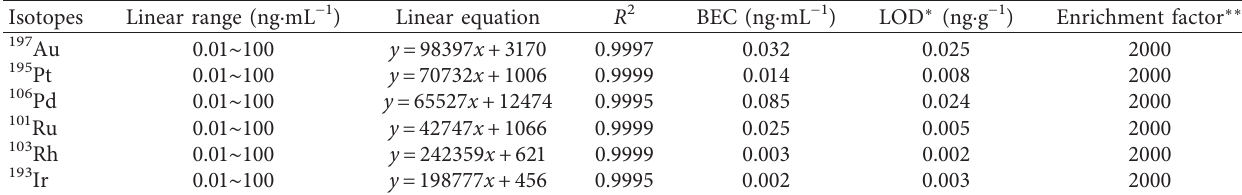
Table 4: Analytical performance data by the established Bi-FA ICP-MS method for Au, Pt, Pd, Ru, Rh, and Ir. Isotopes Linear range (ng · mL − 1